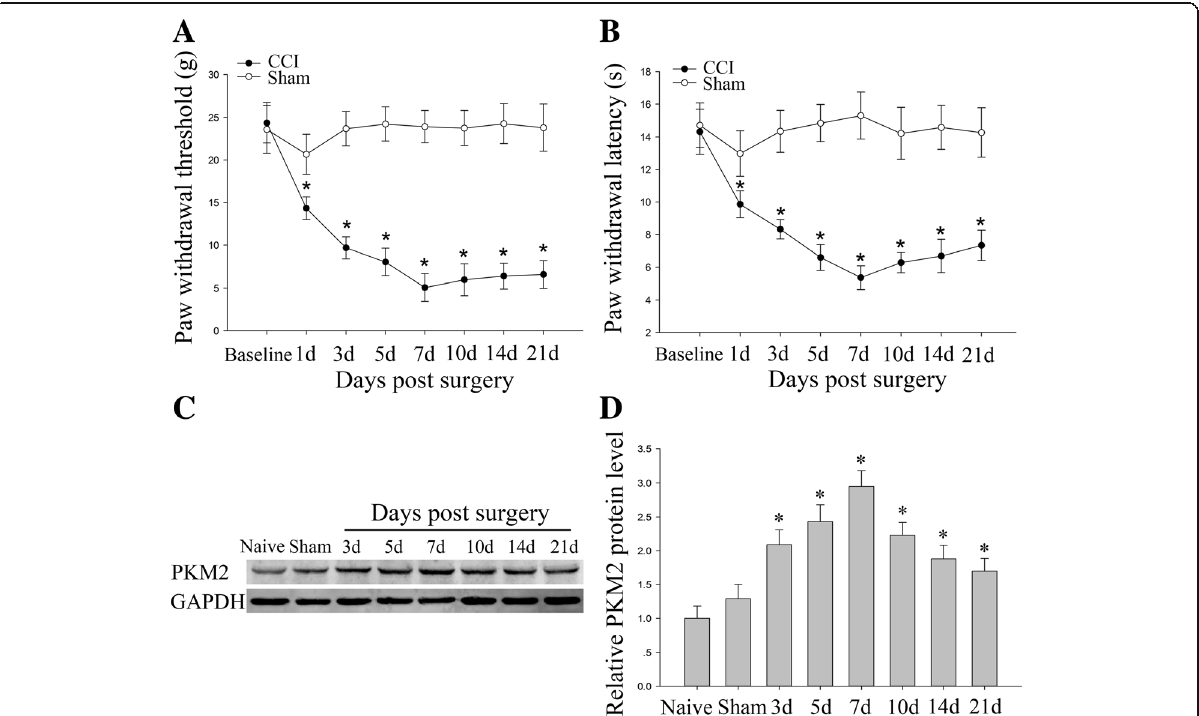
Fig. 1 Changes of mechanical allodynia, heat hyperalgesia and PKM2 expression in rats after CCI. a , b CCI induced a significant decrease in PWT ( a ) and PWL ( b ). * P < 0.05 versus sham group. Five rats per group. c , d Western blot was performed to detect PKM2 expression in spinal cord. Each group comprised four corresponding spinal cord segments. Representative PKM2 protein bands were exhibited on the left ( c ), and statistical analysis histogram was shown on the right ( d ). * P < 0.05 versus sham cell-specific markers at day 7: NeuN (for neurons), GFAP (for astrocytes) and Iba-1(for microglia). As is shown in Fig. 2b, PKM2 co-localized with NeuN, GFAP and Iba-1. These results suggested that PKM2 widely expressed in neurons, astrocytes and microglia cells after CCI.